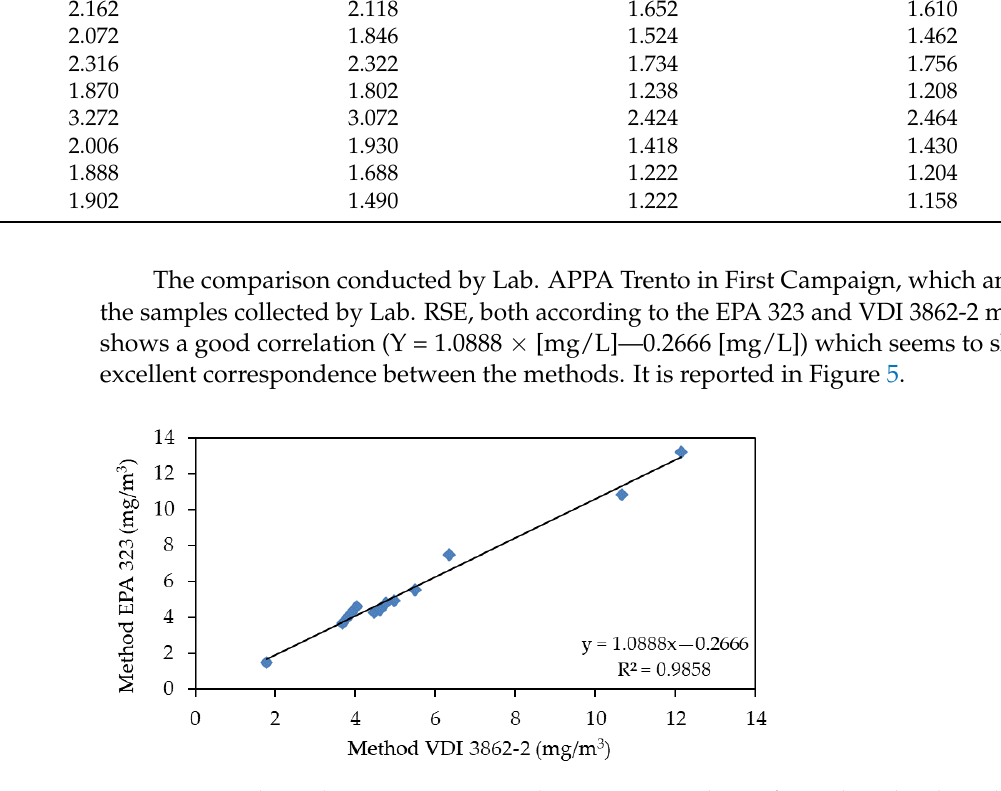
Figure 5. Correlation between EPA 323 and VDI 3862-2 analysis of samples taken by Lab. APPA Trento during First Campaign.